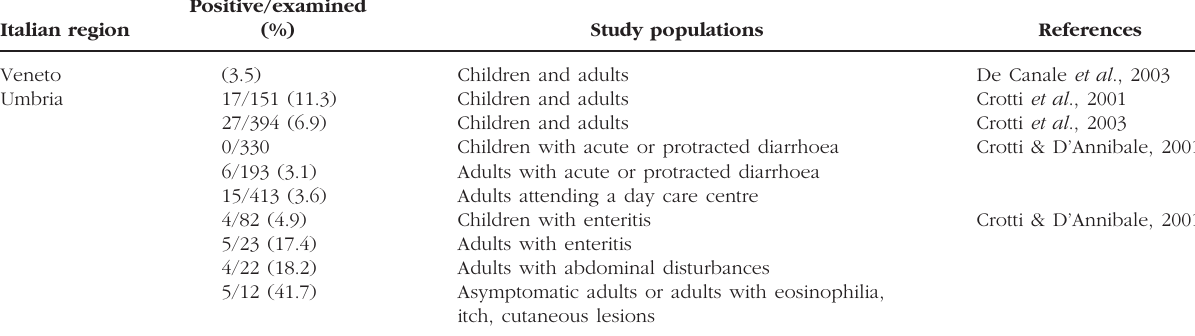
Table IV. – Prevalence of Dietamoeba fragilis in different categories of children and adults according to epidemiological survey carried out in